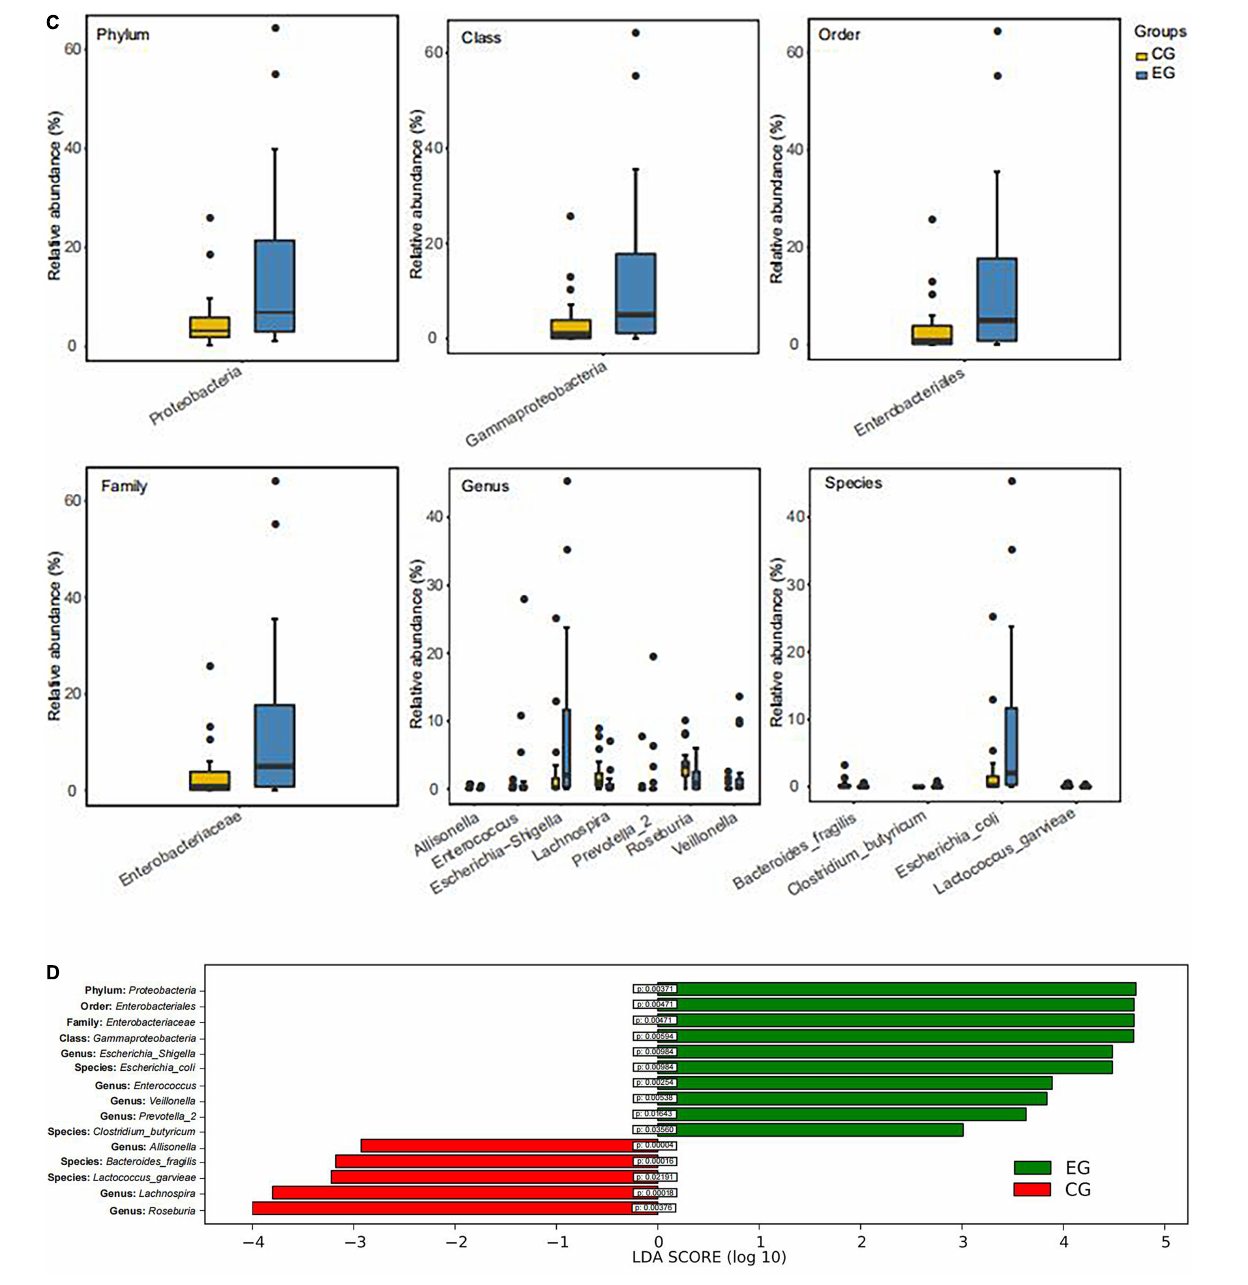
FIGURE 2 | Box diagram of α -diversity index and β -diversity analysis. (A) Evenness and species richness of fecal samples in EG and CG. (B) OTU-based partial minimum multiplicative discriminant analysis showed that there were significant differences between the groups. (C) Difference of flora in phylum, class, order, family, genus, and species between the groups. (D) LDA displays species with significant differences in abundance between two